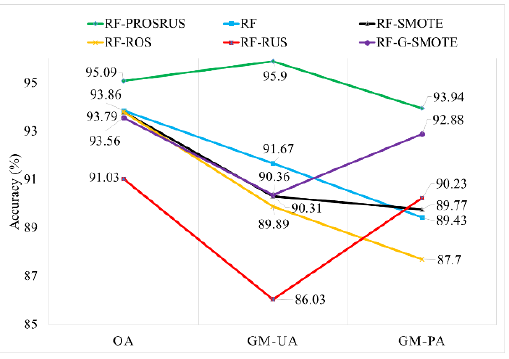
Figure 8. Accuracy assessment of the five resampling methods and the Scenario-4 classification method (i.e., RF with imbalanced samples) over Site-2.